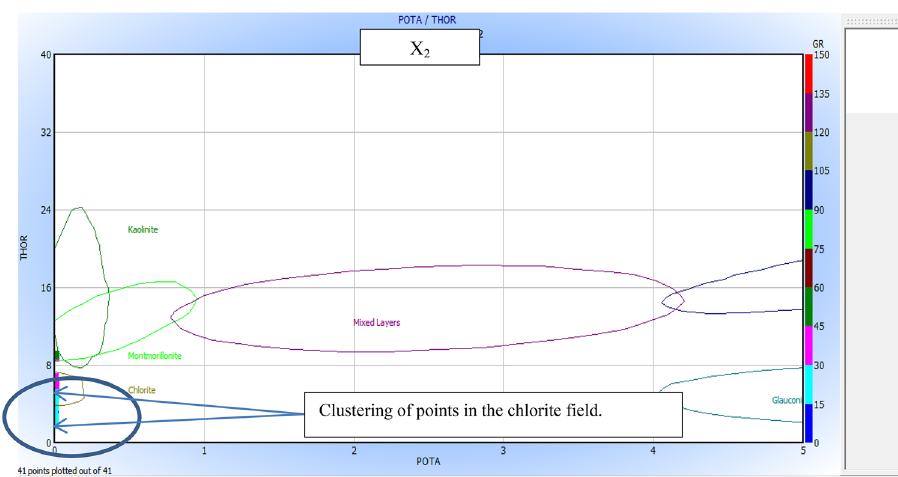
Fig. 14 Thorium–potassium plot for Well X reservoir show- ing most of the points clustering in the